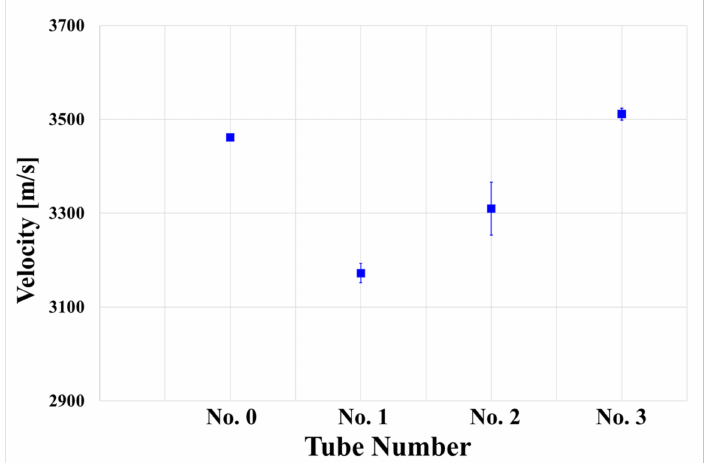
Figure 10. Ultrasonic velocity of the four tube